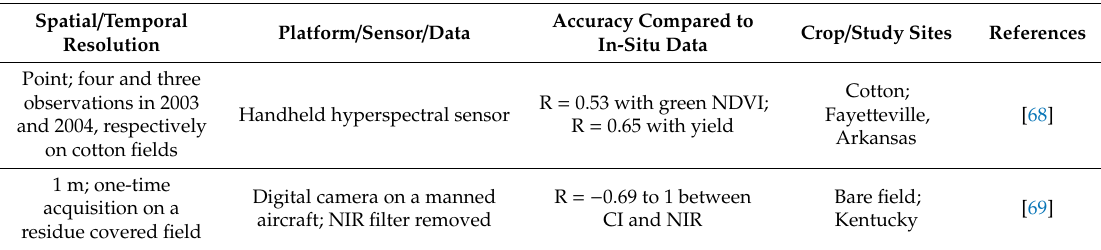
Table 4. Studies focused on soil compaction assessment using RS data from multiple